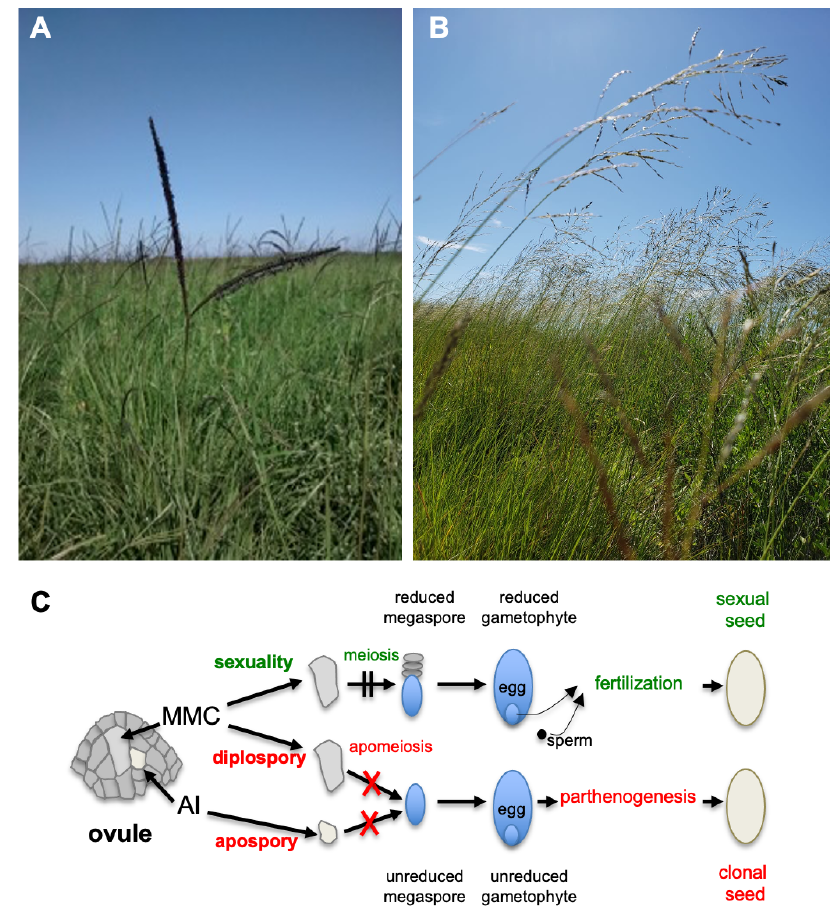
Figure 1. Argentinean apomictic grasses and apomixis reproductive pathways. ( A ) Pastures of Paspalum notatum , an example of aposporous plant. ( B ) Eragrostis curvula , an example of diplosporous plant. ( C ) Schematic representations of sexual and apomictic reproductive pathways. In sexuality (top), a single cell of the ovule enters the germline differentiation program, the so-called megaspore mother cell (MMC). The MMC undergoes meiosis, hence forming a reduced (haploid) functional spore (megaspore), that differentiates into a reduced gametophyte harboring the female gamete (egg). After fertilization of the egg by a sperm cell, a sexual seed is formed. In apomictic pathways, functional unreduced female gametophytes are formed (apomeiosis), and unreduced eggs develop into maternal embryos in the absence of fertilization (parthenogenesis), resulting in seeds containing clones of the mother plant. In diplospory (middle), meiosis in the MMC fails. The unreduced female gametophyte then arises from an unreduced megaspore. In apospory (bottom), one or more somatic ovule cells differentiate into aposporous initials (AIs), the precursor cells of unreduced female